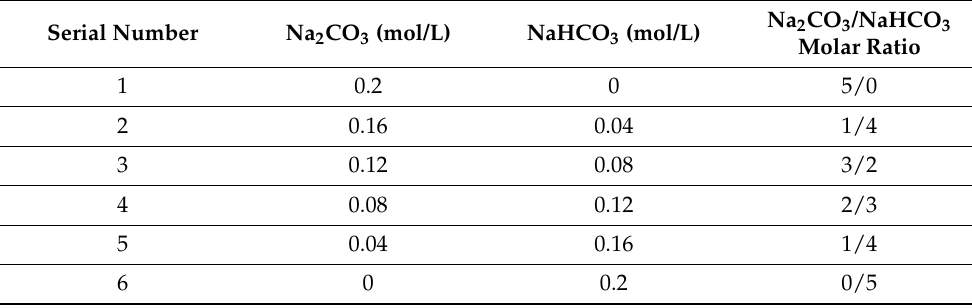
Table 1. Concentrations of sodium carbonate and sodium bicarbonate in the